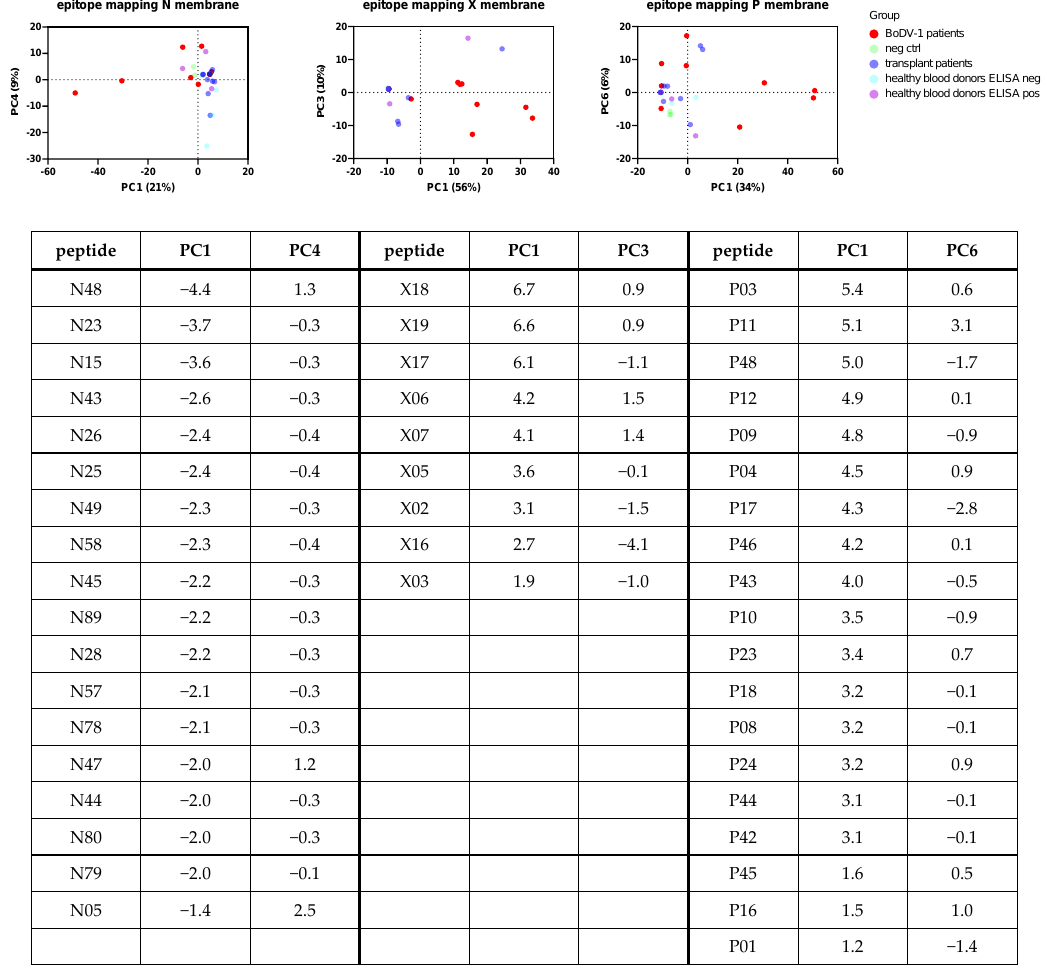
Figure 4. Principal component analysis (PCA) of serological epitope mapping. All 15-mer peptides of N, X, and P proteins were included as individual variables. A PCA test was performed for each membrane separately. Dots represent individual samples of the cohorts of negative controls (green), BoDV-1 patients (red), transplant patients with positive ELISA (blue), healthy blood donors with positive ELISA (purple), and healthy blood donors with negative ELISA (turquoise). Patients with